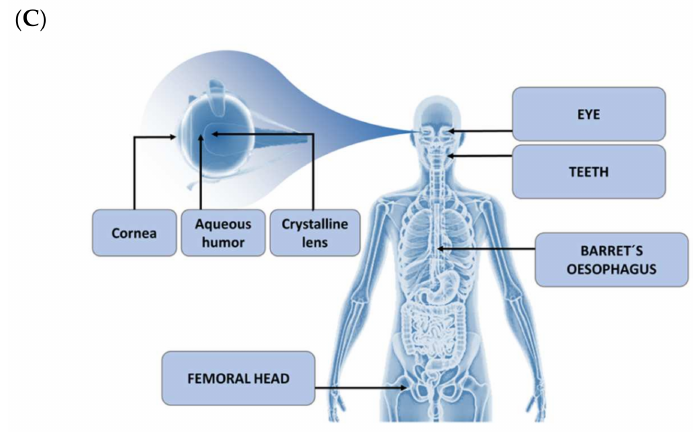
Figure 5. Graphical summary of all the Brillouin studies that have been performed so far regarding each of the cellular components: ( A ) animal models and ( B ) human organs or ( C ) tissues. In ( B ), the most relevant applications of Brillouin spectroscopy are organized by the animal model: ( a ) mouse, ( b ) rabbit, ( c ) zebrafish, and ( d ) cow. Many other studies have employed samples from a wide variety of animals including a pig, rat, and chicken, and less common specimens such as a trout rib, mussel, fowl, and